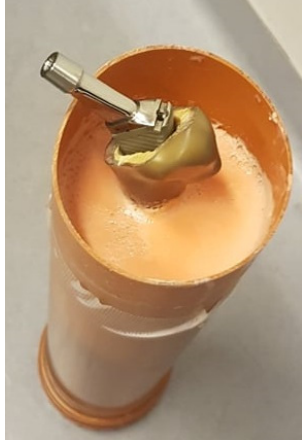
Figure 2. Illustration of the femur–implant structure with artificial soft tissue. The artificial soft tissue is inside the cylindrical container. The illustration shows the initial insertion step.